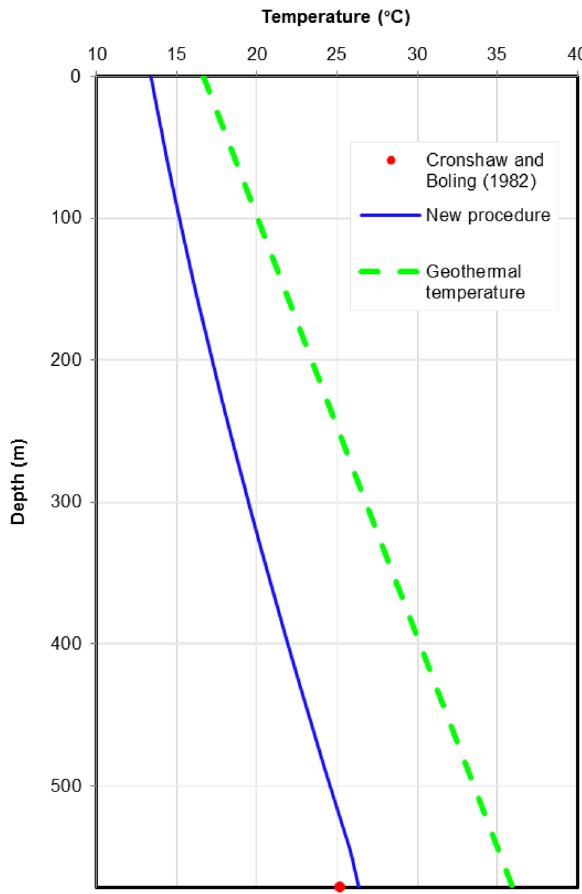
Fig. 7 Comparison of bottomhole temperatures from Cronshaw and Boling (1982) and predicted by the new